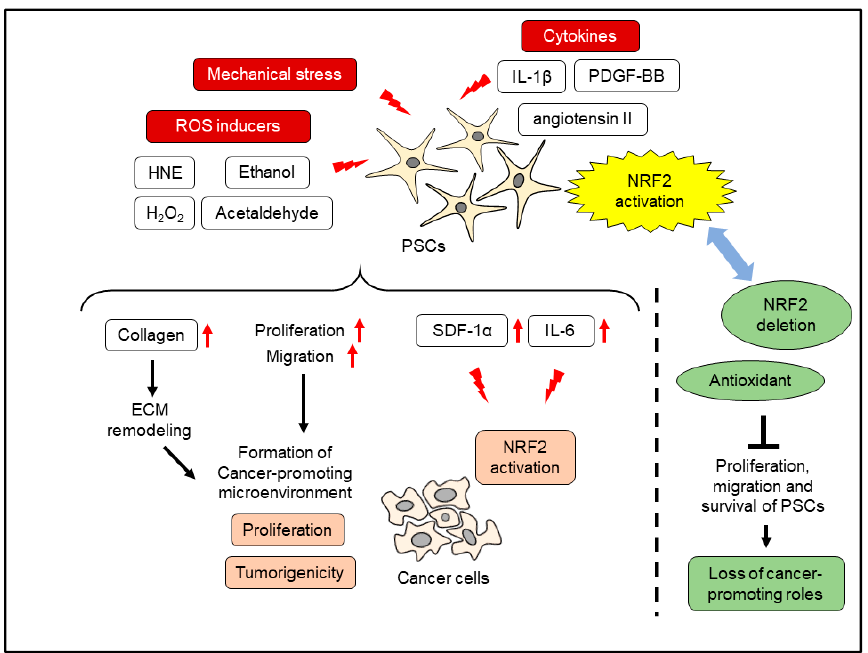
Figure 5. Effects of oxidative stress and NRF2 activation in PSCs. ECM, extracellular matrix; HNE, 4-hydroxy-2,3-nonenal; IL-1 β , interleulin-1 β ; IL-6, interleukin-6; PDGF-BB, platelet-derived growth factor-BB; SDF-1 α , stromal-derived factor-1 α .